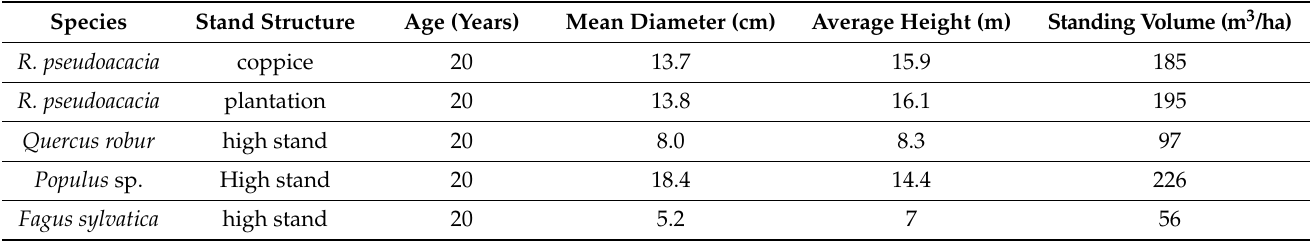
Table 2. Black locust yield compared to main broadleaf species in Romania (for average yield production class III, pure, and even aged stands at 20 years old)